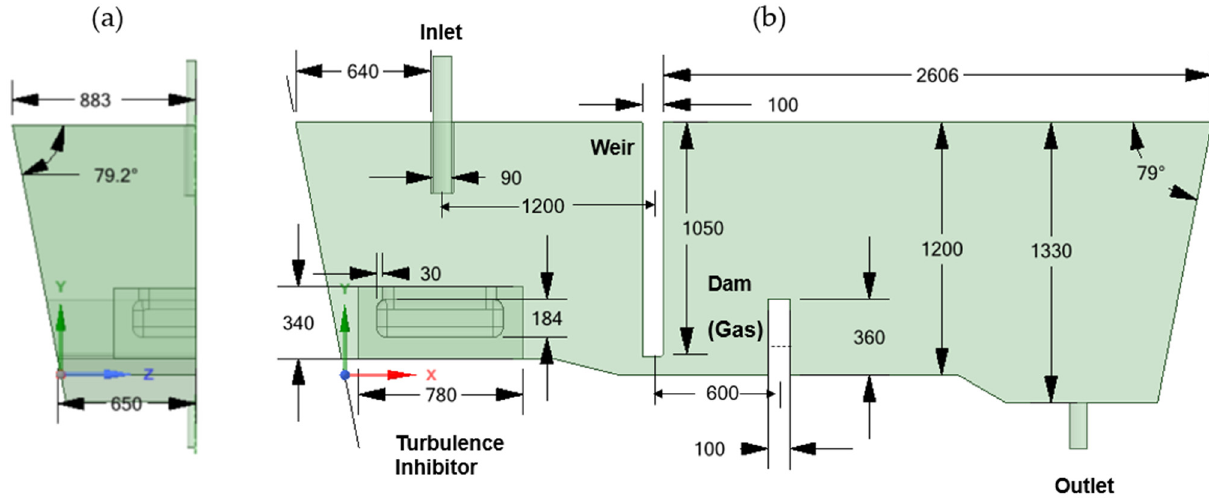
Figure 2. Dimensions of a single-strand tundish with flow control devices of dam (D), weir (W), turbulence inhibitor (TI) or gas curtain (G). ( a ) side view (unit: mm) ( b ) front view (unit: mm).